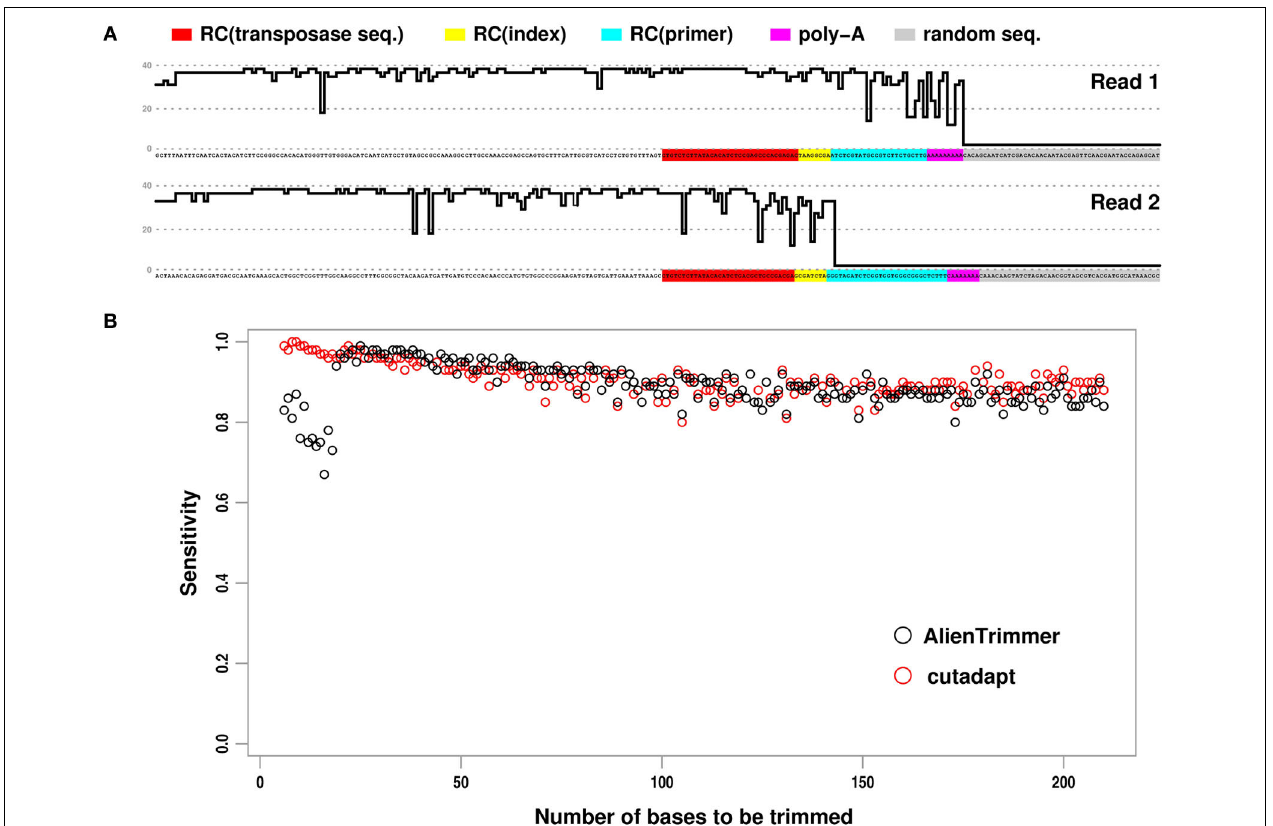
FIGURE 1 | Paired reads containing exogenous oligonucleotide sequences to be trimmed off, and performance results of two trimming programs. (A) Example of short-insert paired-end read with small insert size. Phred quality score Q (up to 40) of each nucleotide is represented by skyline